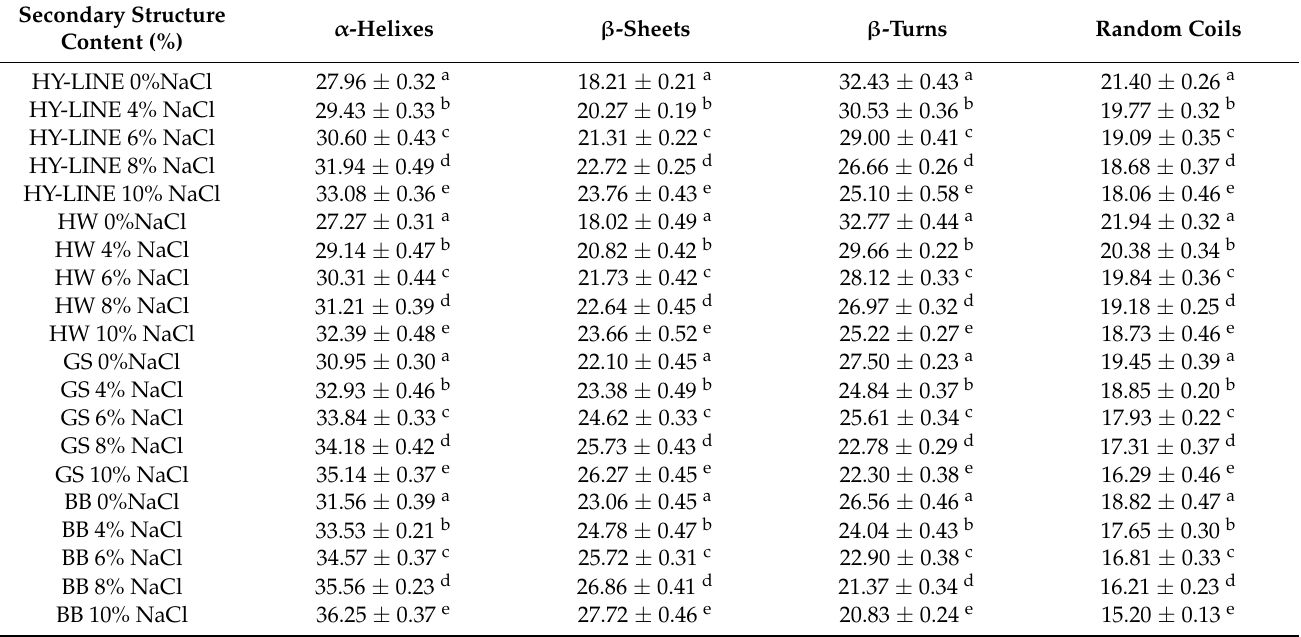
Table 3. Content of α -helixes, β -sheets, β -turns and random coils in four varieties after addition of NaCl and subjection to heat treatment.